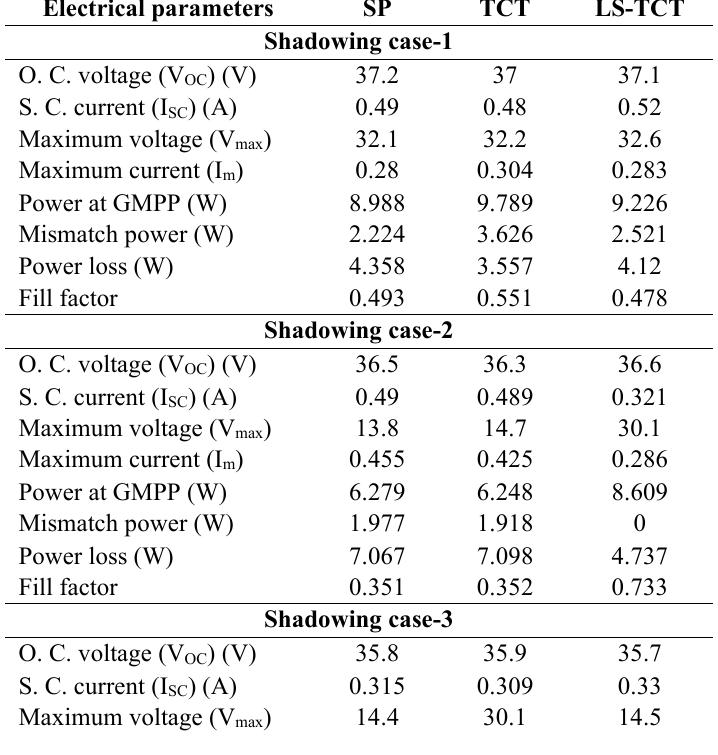
A statistically based detailed comparison of all important performance parameters, such as voltage and power at GMPP, power loss and FF of all configurations under shadow test cases, is rendered and graphically shown in Figure 10(a)- (d). Moreover, the quantitative analysis of entire performance parameters of PV system is depicted in Table-3 as, Table 3. Performance parameters of SP, TCT and LS-TCT configurations under shadow